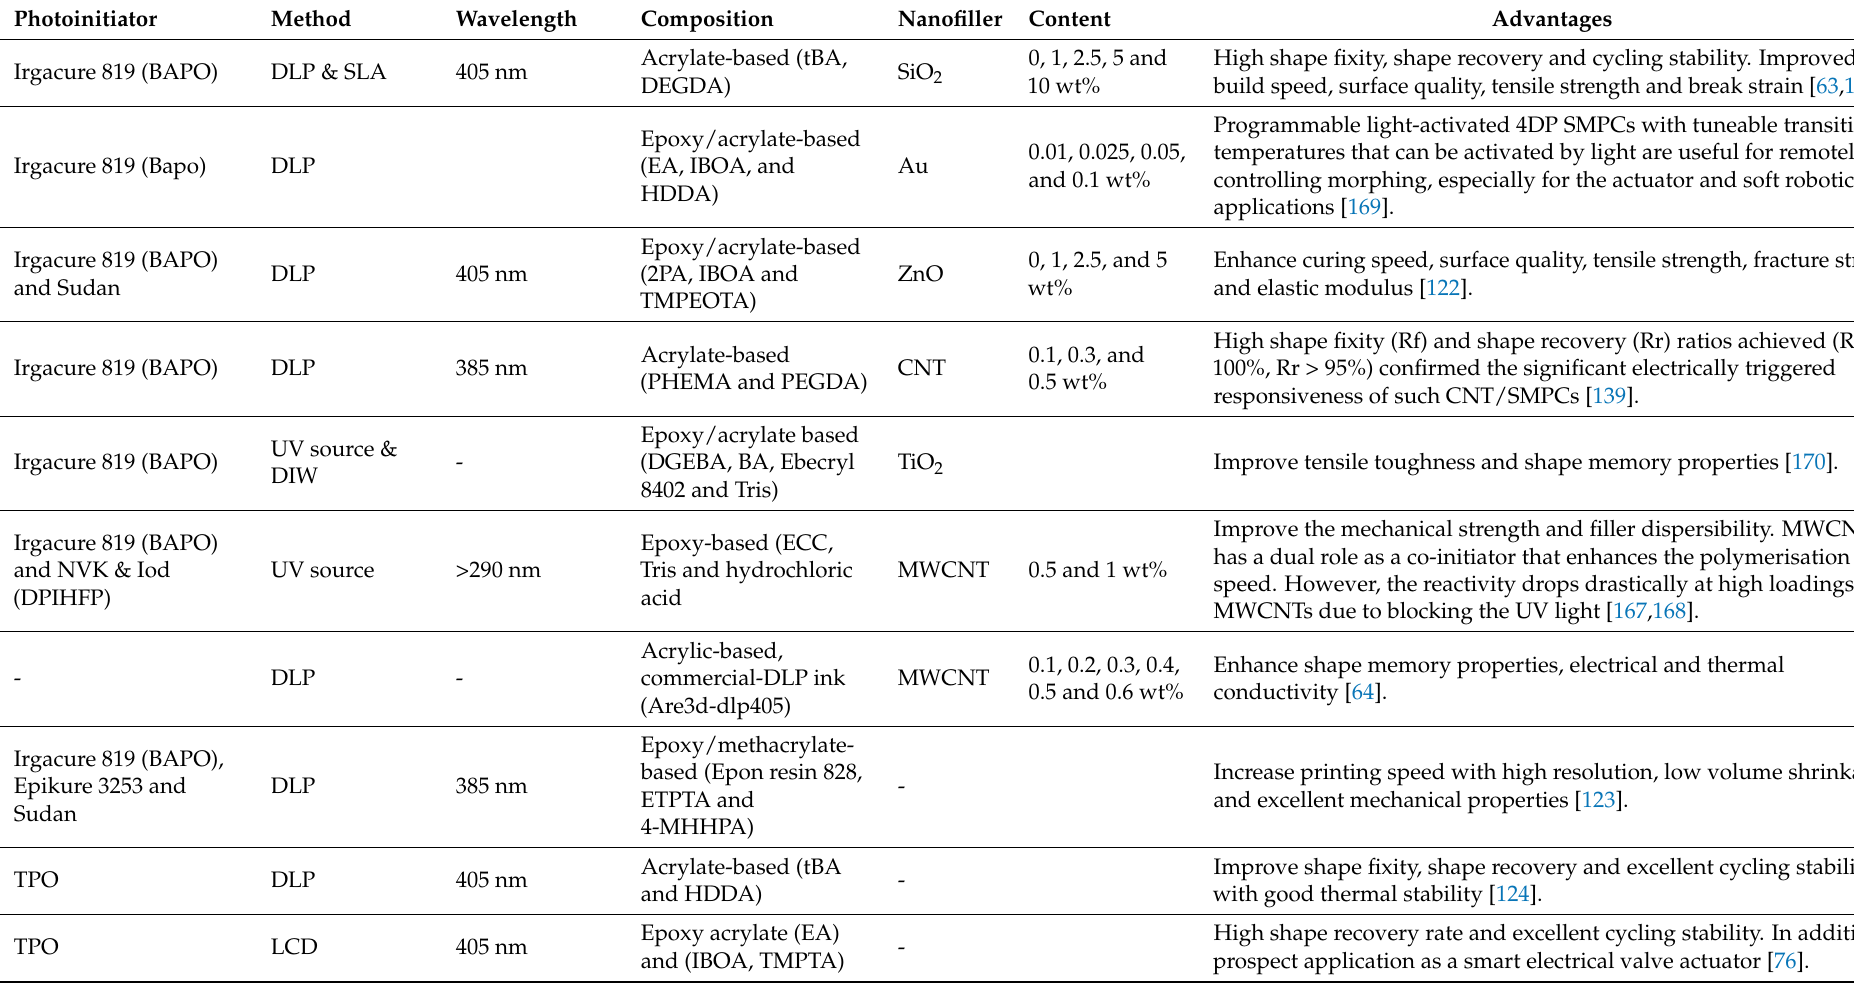
Table 1. List of radical and cationic photopolymerisation systems and their advantages for additive